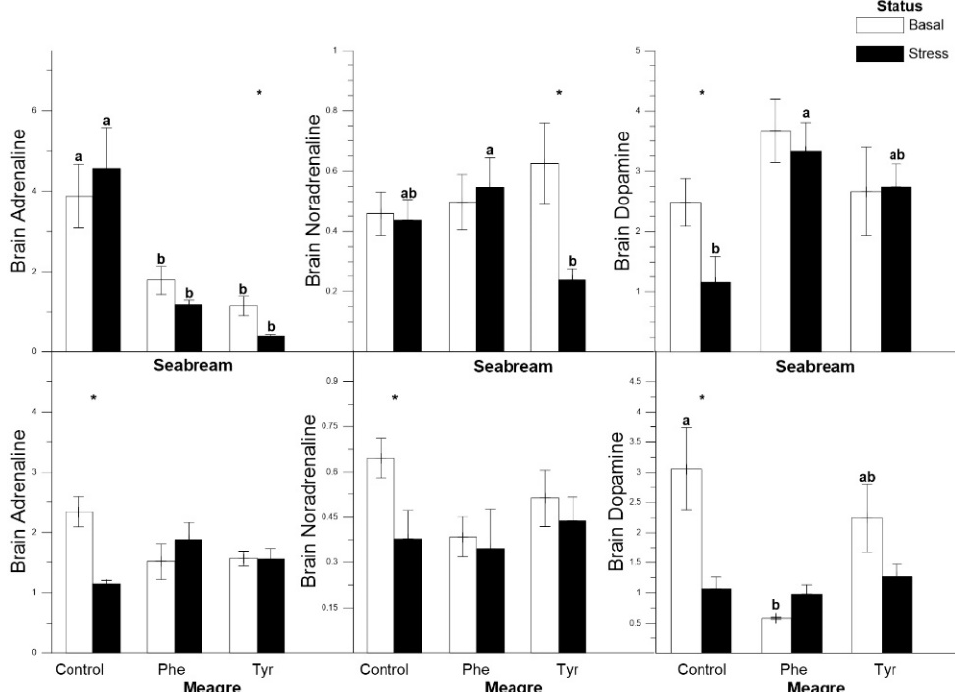
Figure 4. Brain adrenaline, noradrenaline and dopamine concentrations (ng mL − 1 ), for each treat- ment (mean ± SE, n = 10). The white and black bars are the basal and stress values, respectively. Asterisks indicate significant differences between the basal and stress conditions. Different letters indicate significant differences among feeding treatments within every